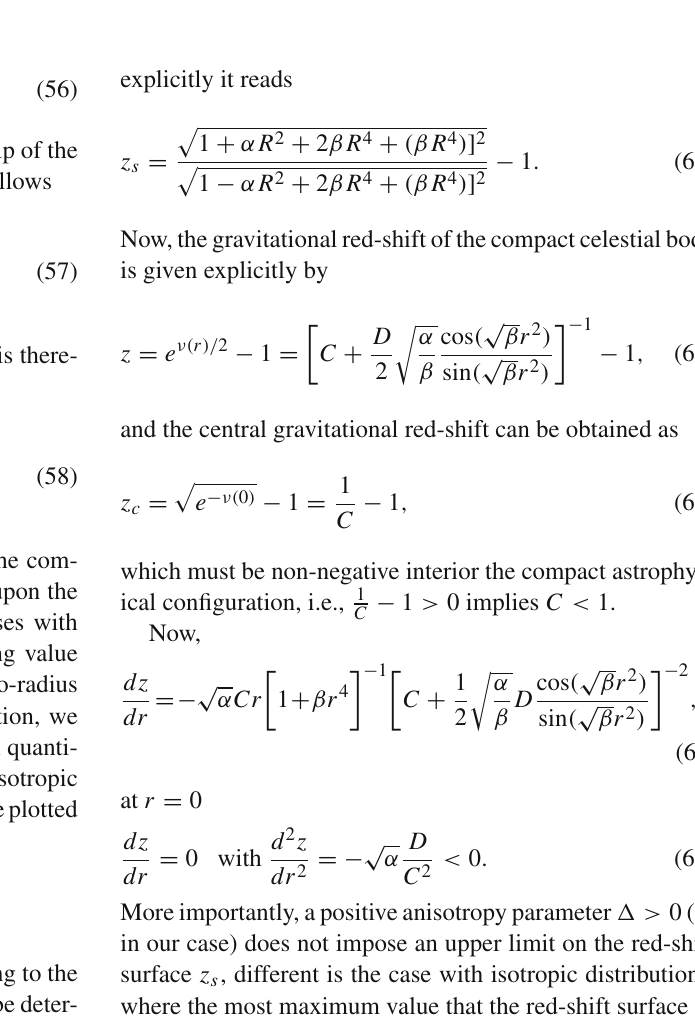
plotting these graphs, the numerical values for the constant parame- ters are α = 0 . 030390 / km 2 , β = 0 . 000075 / km 4 , C = 0 . 9985 and D = 0 .